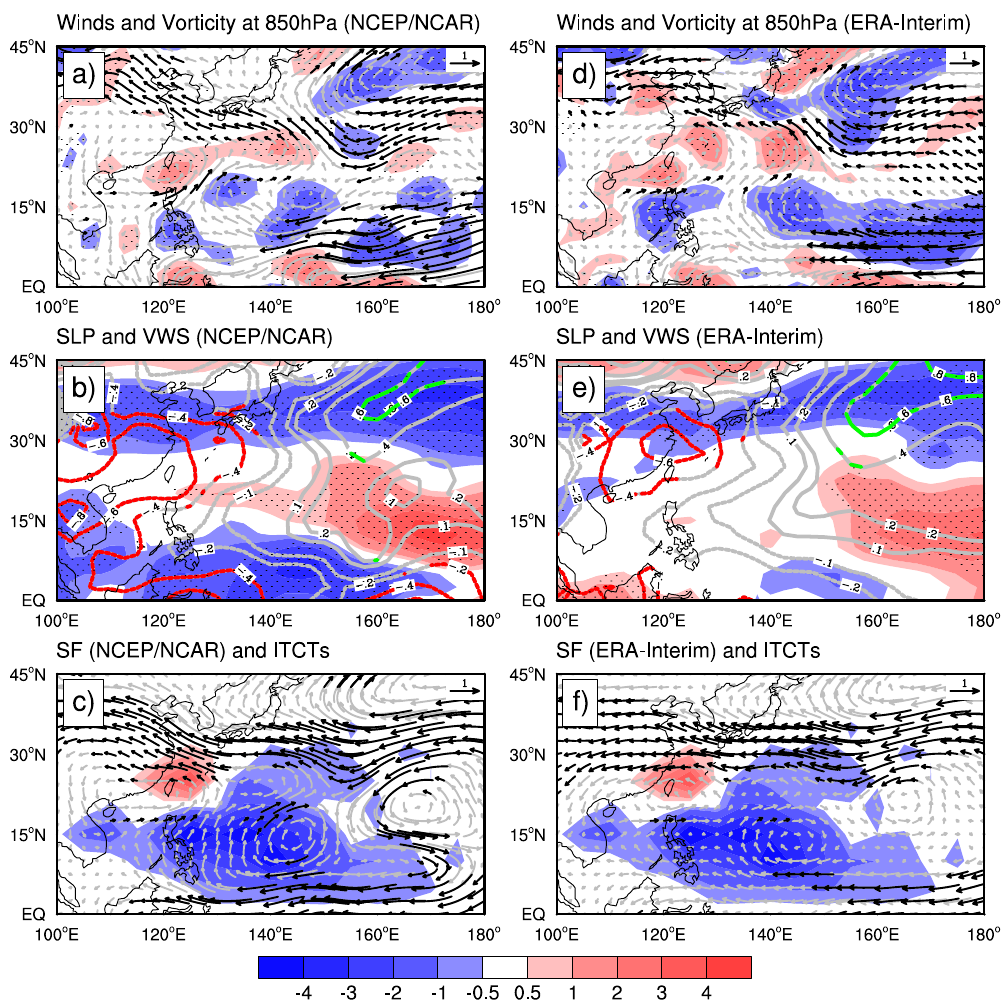
(contours in hPa) and VWS between 200 and 850 hPa (shades in m s − 1 ), and ( c , f ) mass-weighted mean winds between 300 and 850 hPa (SF, vectors in m s − 1 ) over the Northwest Pacific between the hiatus (1998–2015) and pre-hiatus (1980–1997) periods based on ( a – c ) the NCEP/NCAR and ( d – f ) the ERA-Interim reanalysis data. Shades in ( c ) and ( f ) indicate the differences in ITC occurrence in the two periods as in Fig. 1a but divided by factor of 5 for sharing the same color bar. All difference fields were averaged in JASON. Black vectors, red and green lines, and dots represent areas where the differences are statistically significant at the 90% confidence level using Mann-Whitney U test. This figure was generated by the NCAR Command Language (Version 6.4.0) [Software]. (2017). Boulder, Colorado: